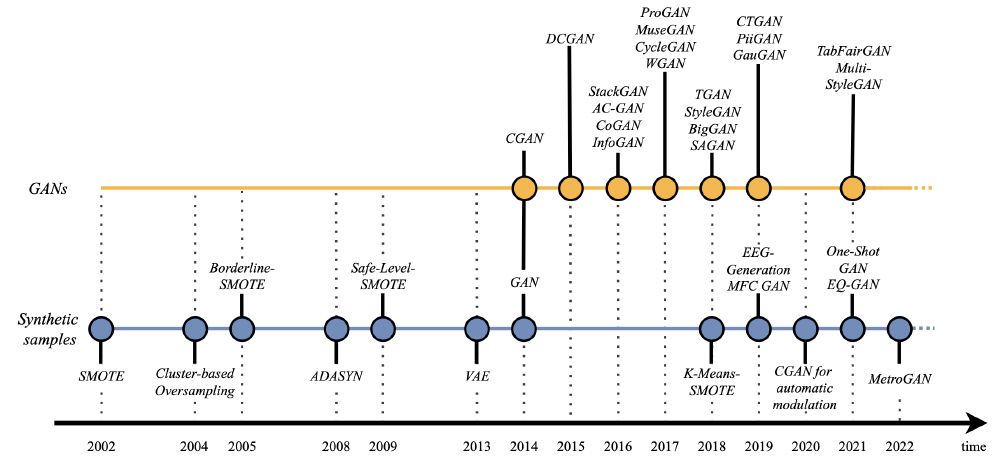
Figure 29. Timeline showing the different GAN architectures (in orange) and the generation of the synthetic sample methods (in blue) covered in this work.